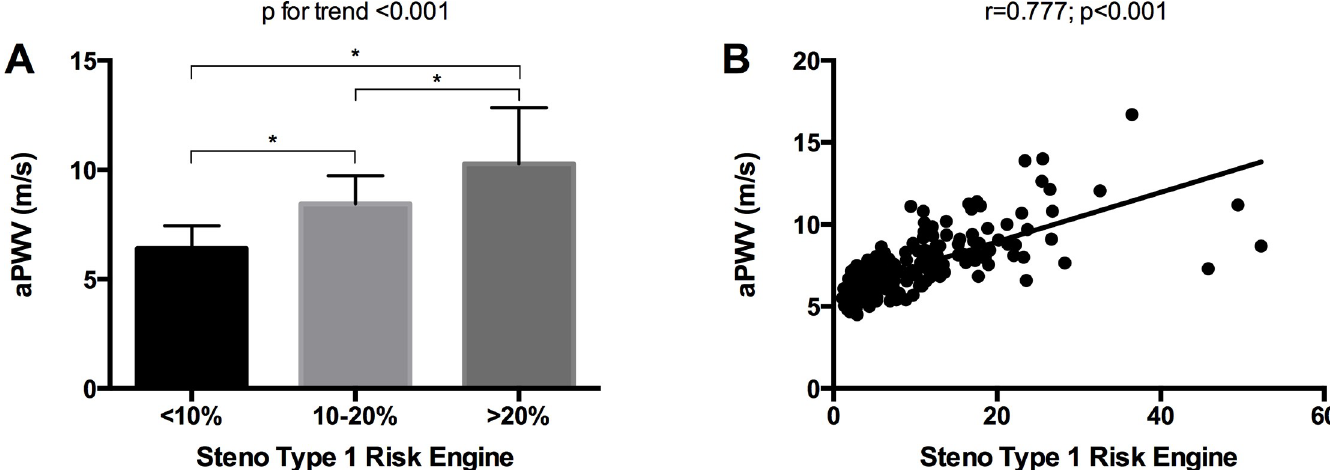
Fig 1. A. Comparison of aortic pulse wave velocity (aPWV) for the Steno Type 1 Risk Engine (ST1RE) low- ( < 10%), moderate- (10–20%) and high-risk ( � 20%) groups ( � p < 0.05 for multiple comparison). B. Spearman correlation coefficient for the association between aPWV and ST1RE risk score.